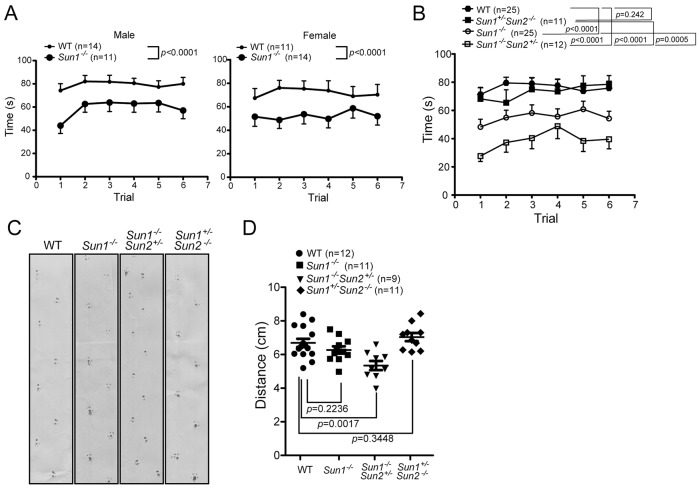
The coordinated movement of mice deficient for Sun1 and/or Sun2. (A) Motor coordination of 3- to 4-month-old WT and Sun1−/− mice was tested using rotarod. The number of mice tested for each gender are indicated. The time to fall off the rotarod (latency) was recorded. (B) Similar to A, the time to fall off the rotarod from age-matched (3-4 months old) animals with genotypes WT, Sun1−/−, Sun1+/−Sun2−/−, and Sun1−/−Sun2+/−. Mean±s.e.m. for each genotype is presented. (C,D) Footprint analysis obtained from 5- to 6-month-old WT, Sun1−/−, Sun1+/−Sun2−/−, and Sun1−/−Sun2+/− animals. (D) Footprint analysis statistics and the mean±s.e.m. for each genotype is presented. Each data point represents the averaged stride length from 5 or 6 steps of each mouse. Student's t-test.